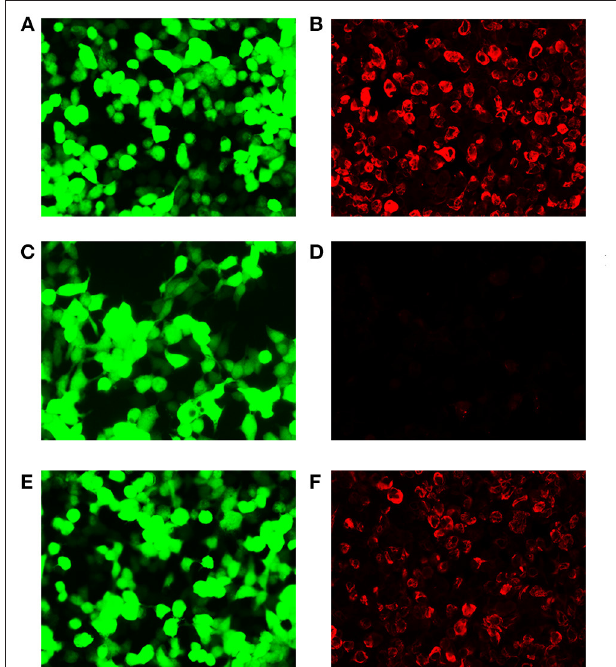
FIGURE 1 | Demonstration of GFAP-IgG by GFAP-transfected HEK293 cell-based immunofluorescence assay. (A,C,E) HEK293 cells expressing green fluorescent protein (GFP)-tagged GFAP (green). (B,D,F) HEK293 cells immunostained (red if positive); (B) Positive control with human anti-GFAP α IgG. (D) Negative with healthy control. (F) Positive result of cerebrospinal fluid (CSF) (titer at 1:32). Scale bar = 50 µ m.